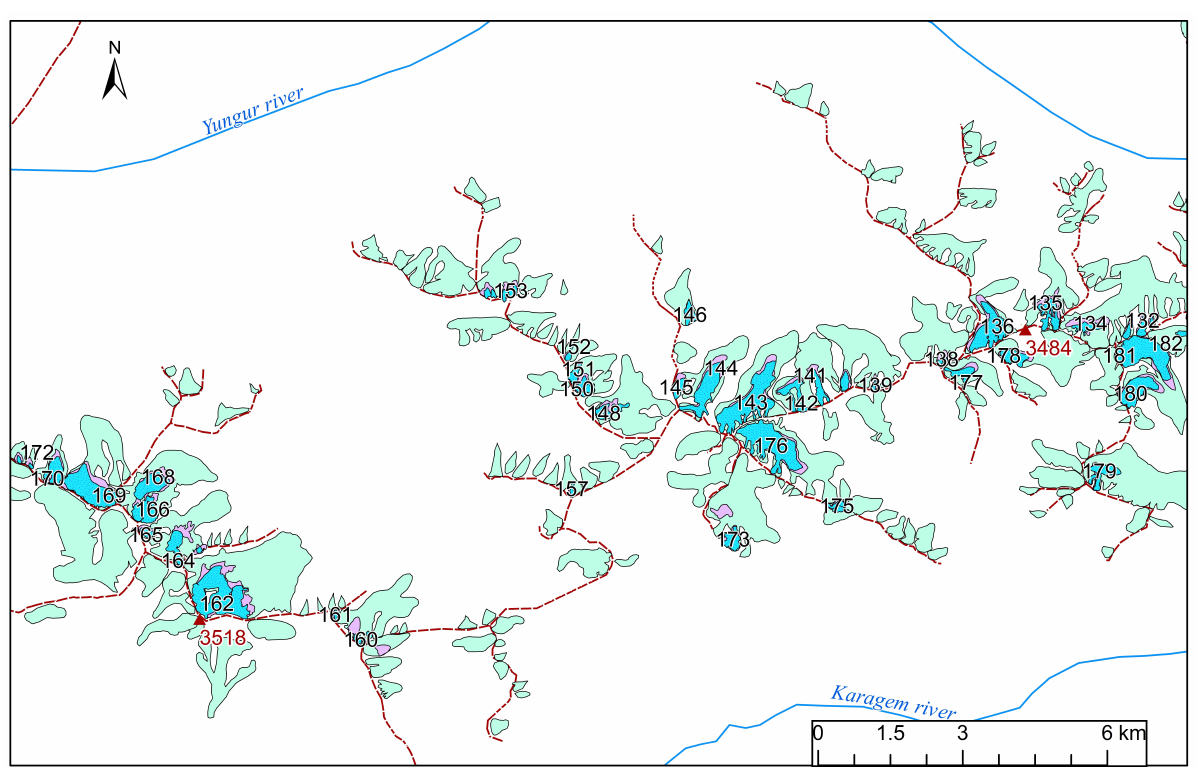
Figure 9. Reduction of the glaciers of the western periphery of the North-Chuya range, the basins of Yungur (lower part), Argut, and Karagem (lower part) rivers, after the LIA maximum.